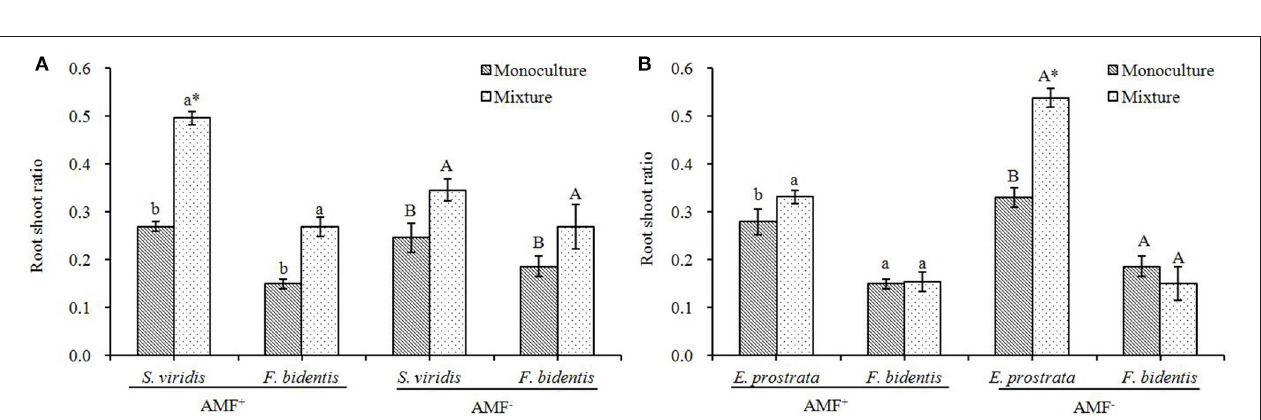
FIGURE 4 | Effects of R. intraradices on corrected index of relative competition indensity (CRCI) of exotic plant F. bidentis and two native plants S. viridis (A) and E. prostrata (B) . Different lower case letters indicate significant difference between inoculation and non-inoculation treatments at P < 0.05. Error bars represent ± SE of mean ( n = 5).